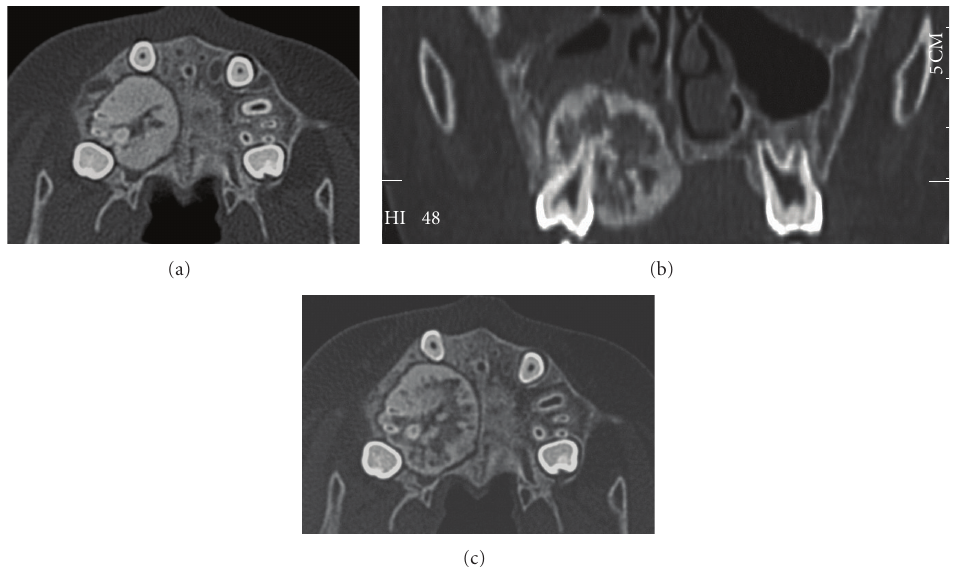
Figure 2: (a) The tumour contained low-density and cemental regions. (b) CT showing penetration into the nasal cavity and maxillary sinus. (c) The tumour showed rapid expansion over 2 months.